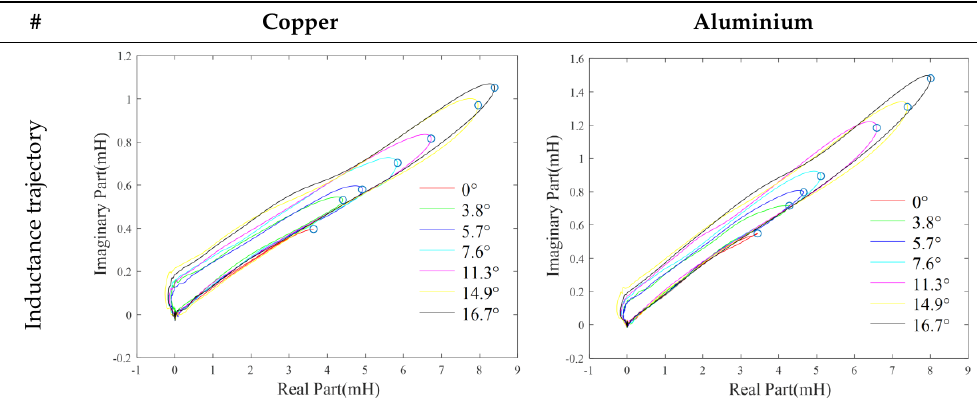
Table 2. Approximate linear relationship between the endpoint of inductance trajectory (marked by circles) and tilt angles [53].